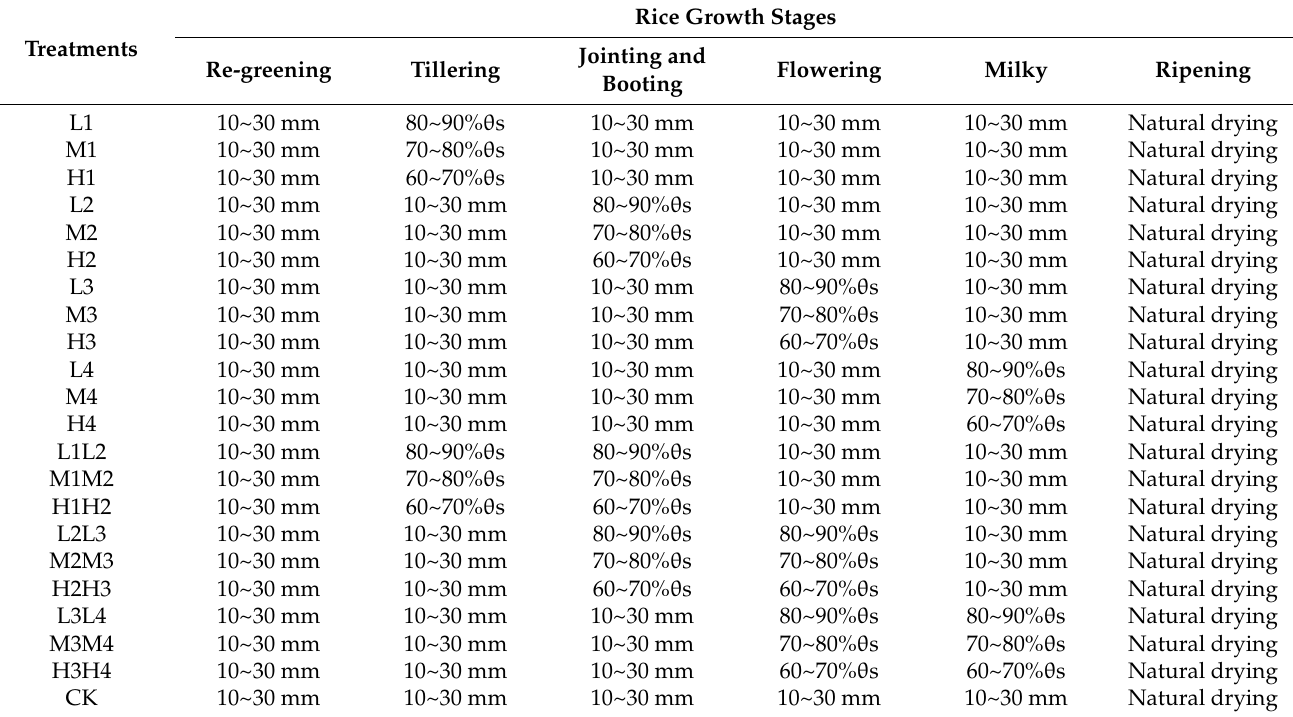
Table 3. Irrigation methods in different growth stages of all treatments in 2017 and 2018. Rice Growth Stages Treatments Tillering